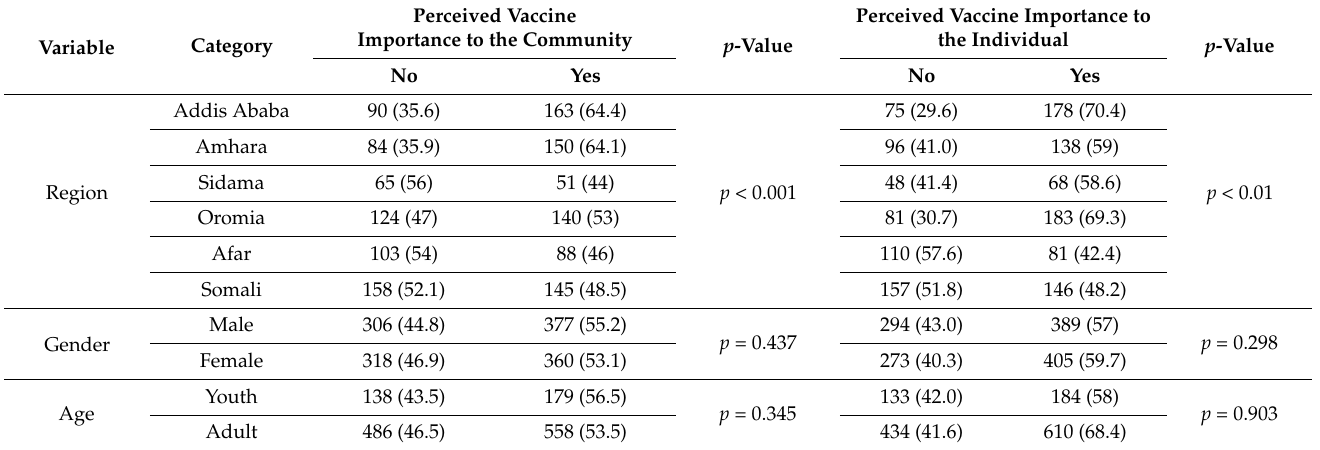
Table 9. Study participants perceived community and individual benefits of COVID-19 vaccination at the time of the vaccine hesitancy survey, Ethiopia,